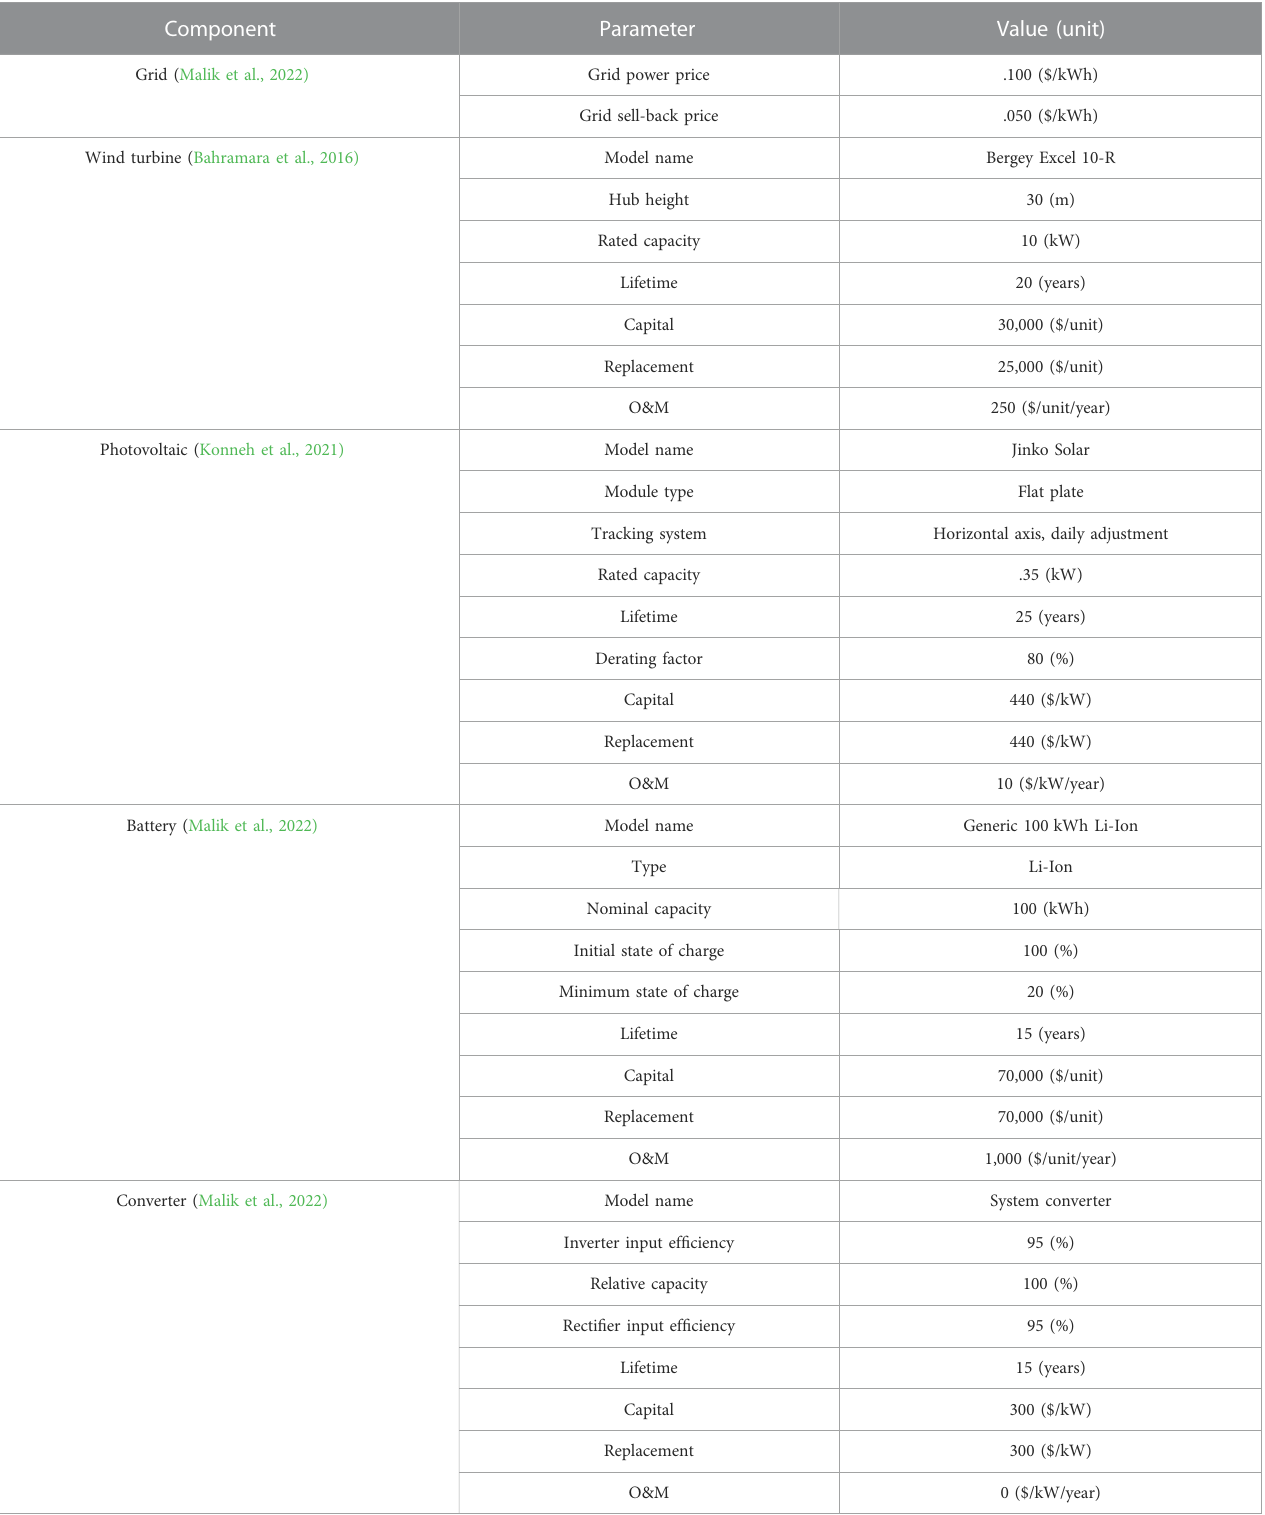
TABLE 1 Components of the system and their parameters (Iqbal et al., 2022a). Component